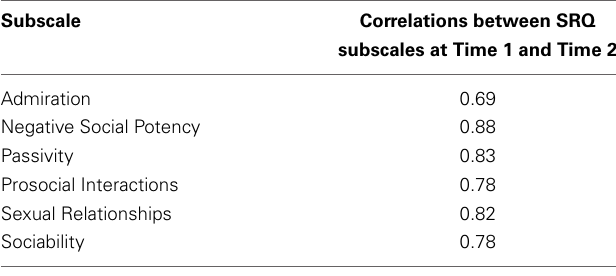
Table 4 | Test-retest reliability: Pearson correlations between factor subtotal scores at Time 1 and Time 2 (mean time interval = 12 days).